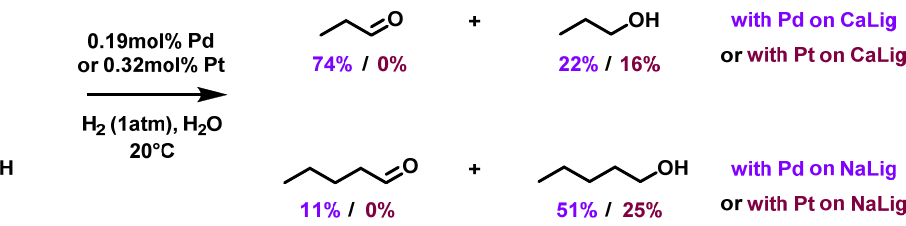
Figure 27. Examples of results obtained with palladium or platinum nanoparticles deposited on sodium or calcium lignosulfonate in the hydrogenation of allylic alcohols by d’Alessandro and Tonucci et al. [163].